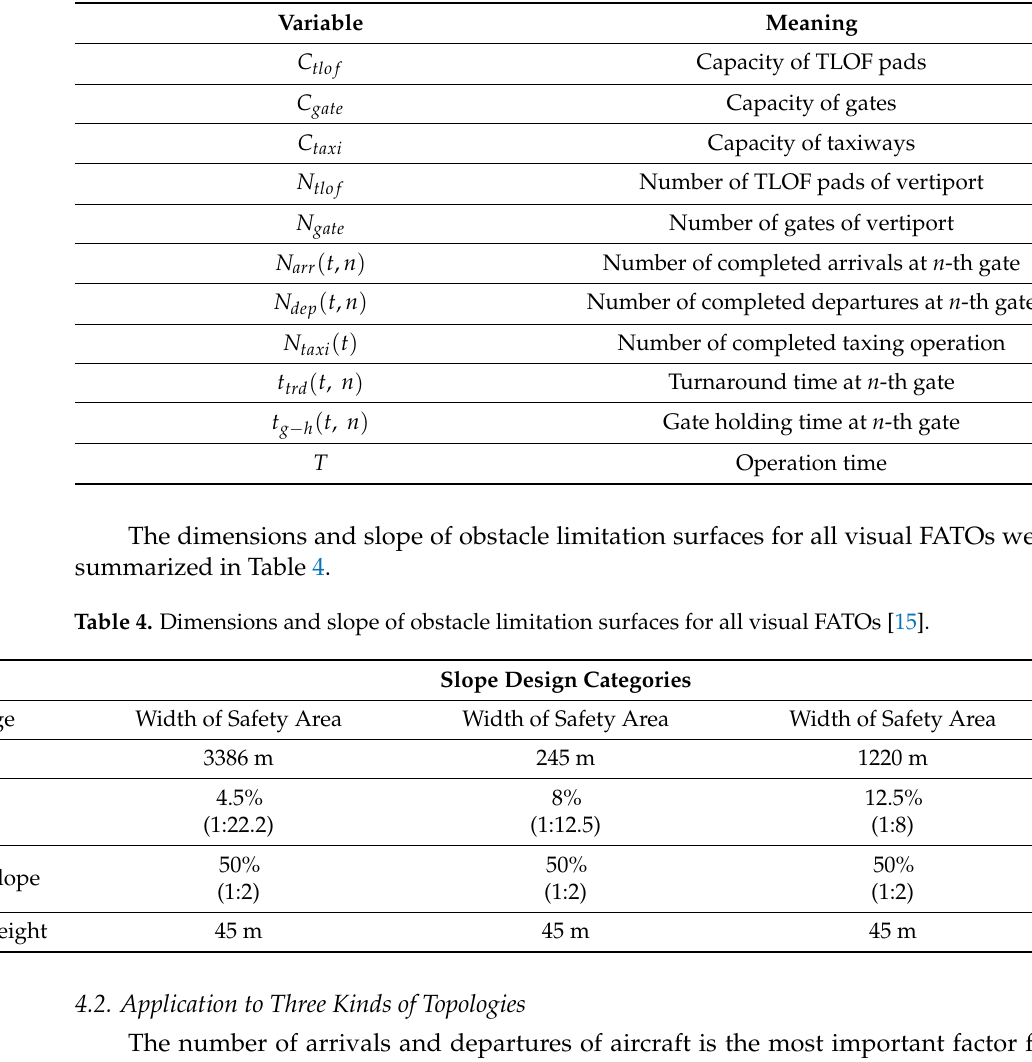
Table 3. Variables for capacity determination algorithm.